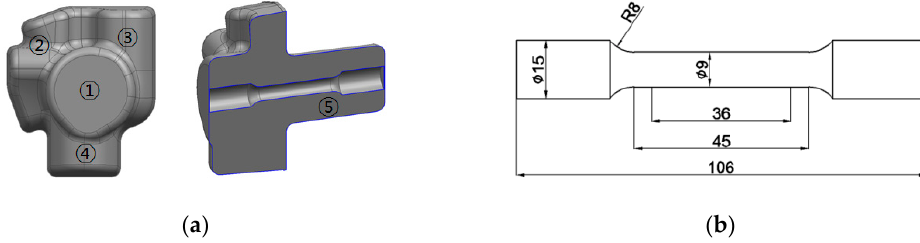
Figure 5. Position and dimension of tensile specimen and position of Vickers hardness: ( a ) Position of measurement ( ① ~ ⑤ : for Vickers hardness); ( b ) Dimension of tensile specimen.